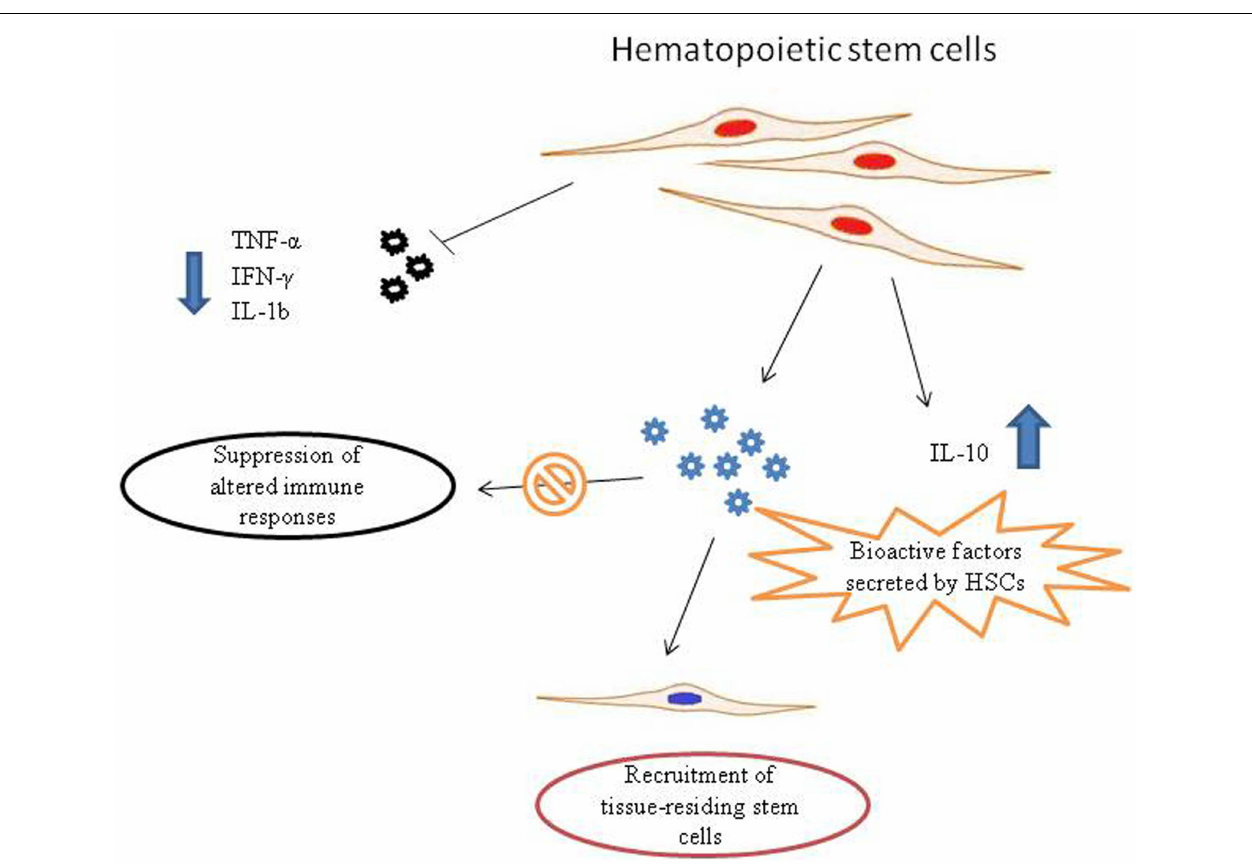
secreted from stem cells are able to suppress aberrant immune responses and stimulate recruitment, retention, and activation of tissue-residing stem cells. In addition, HSCs are able to down-regulate the pro-inflammatoryTNF- α , IFN- γ , and IL-1, that are responsible for neuroinflammatory processes in ASDs, as well as to up-regulate the anti-inflammatory cytokine